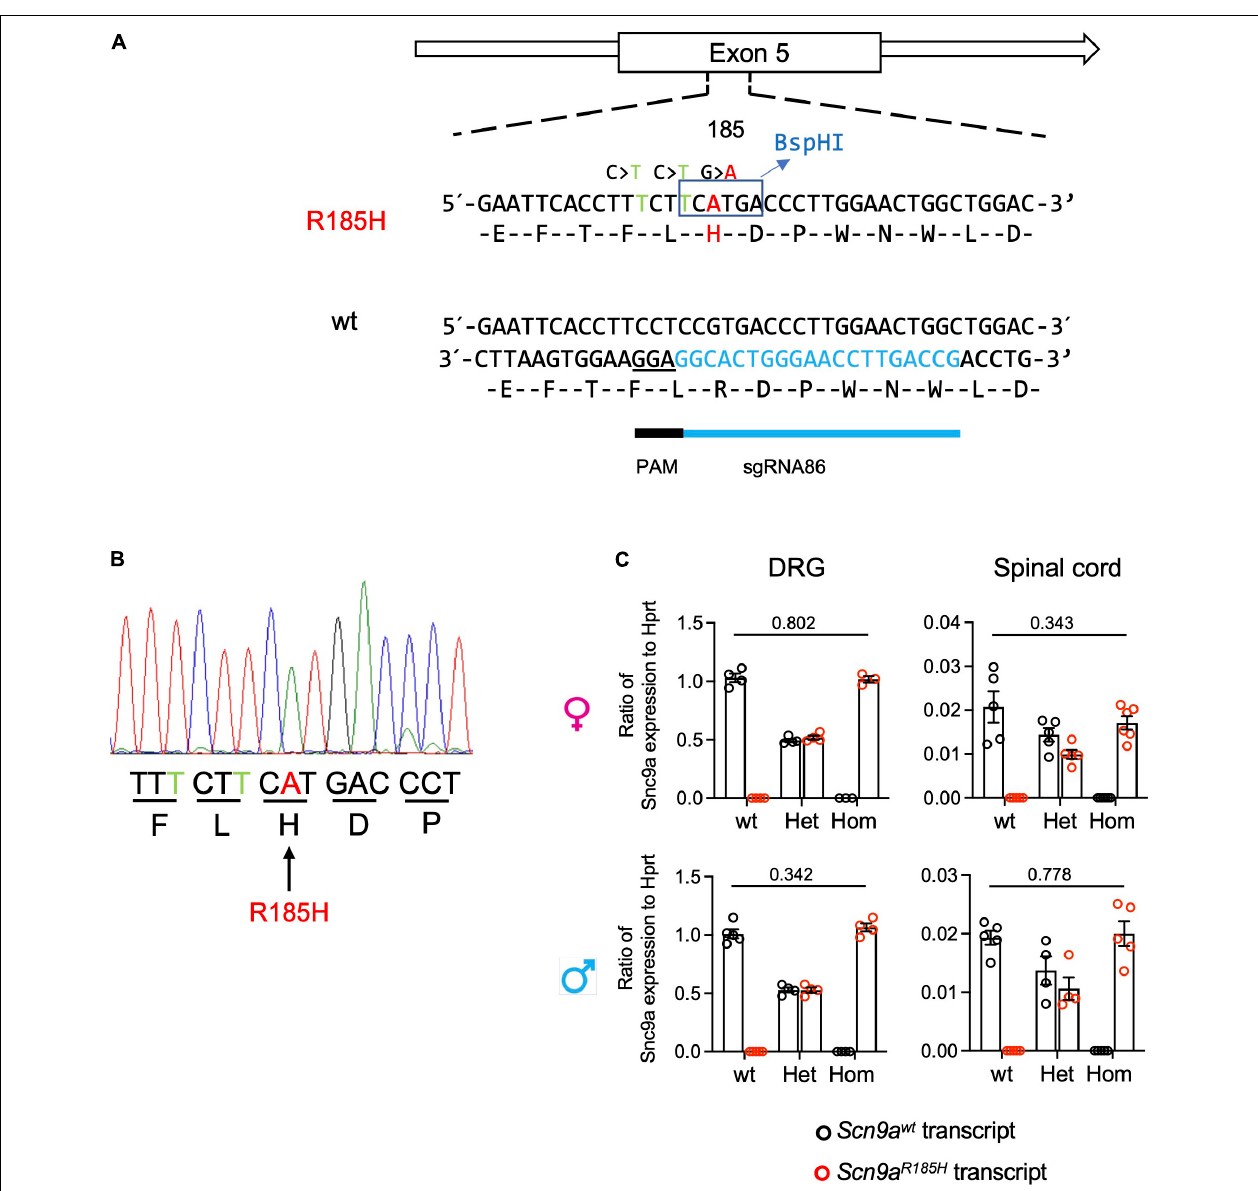
FIGURE 1 | Generation of Scn9a R 185 H mutant mice and Scn9a transcript expression in wild-type (wt) and mutant mice. (A) Scheme for Scn9a targeting strategy. The sgRNA86 guide RNA and protospacer adjacent motif (PAM) are shown. The ssODN contained three basic mutations including two silent mutations and one-point mutation. The first silence mutation, C > T was PAM mutation designed to avoid Cas9 recut. The second mutation, C > T, was designed for Bsp HI enzyme restriction site for genotyping. The third G > A mutation was designed to get the R185H found in human patients. (B) Mutant allele sequence characterized through Sanger sequencing of F0 founder DNA. The silence-mutated nucleotides are indicated in green and targeted point mutant nucleotide in red. (C) Scn9a micro-RNA (mRNA) expression in dorsal root ganglia (DRG) and spinal cord, of wt and Scn9a R 185 H mutant mice of both sexes. There was no significant effect of genotype. DRG. females: wt n = 4; Het n = 4; Homo n = 3; males: wt n = 5; Het n = 4; Homo n = 4; Spinal cord. Females: wt n = 5; Het n = 5; Homo n = 6; males: wt n = 5; Het n = 4; Homo n = 5. Scn9a transcript expression was normalized to Hprt expression. Results are shown as means ± SEM. Two-tailed